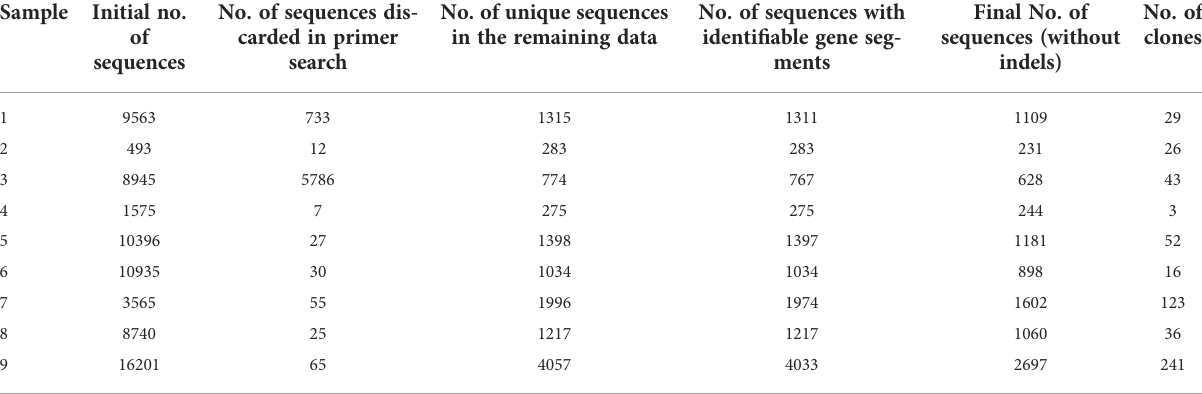
TABLE 2 Numbers of sequences following each stage of cleaning for all samples 1 . Sample Initial no. of